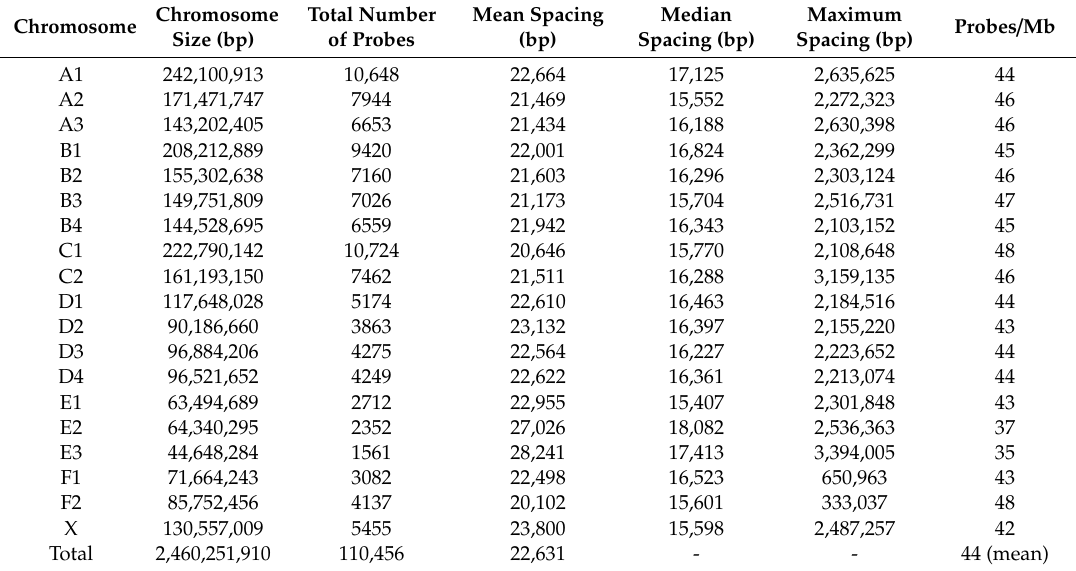
Table 1. Summary of probe distribution on the feline oaCGH array. The physical size of each chromosome is shown along with the corresponding number of validated probes developed for the final array design. The mean and median probe spacing demonstrates the global comparability of probe distribution for each chromosome, with an overall 22.6kb spacing at the genome-wide level, equating to an average of 44 probes per Mb of sequence. The lower values for maximum spacing on fcaF1 and F2 reflect the acrocentric nature of these chromosomes, while the remaining chromosomes, all of which are biarmed, are impacted more heavily by the confounding e ff ect of centromeric repeat sequence on probe